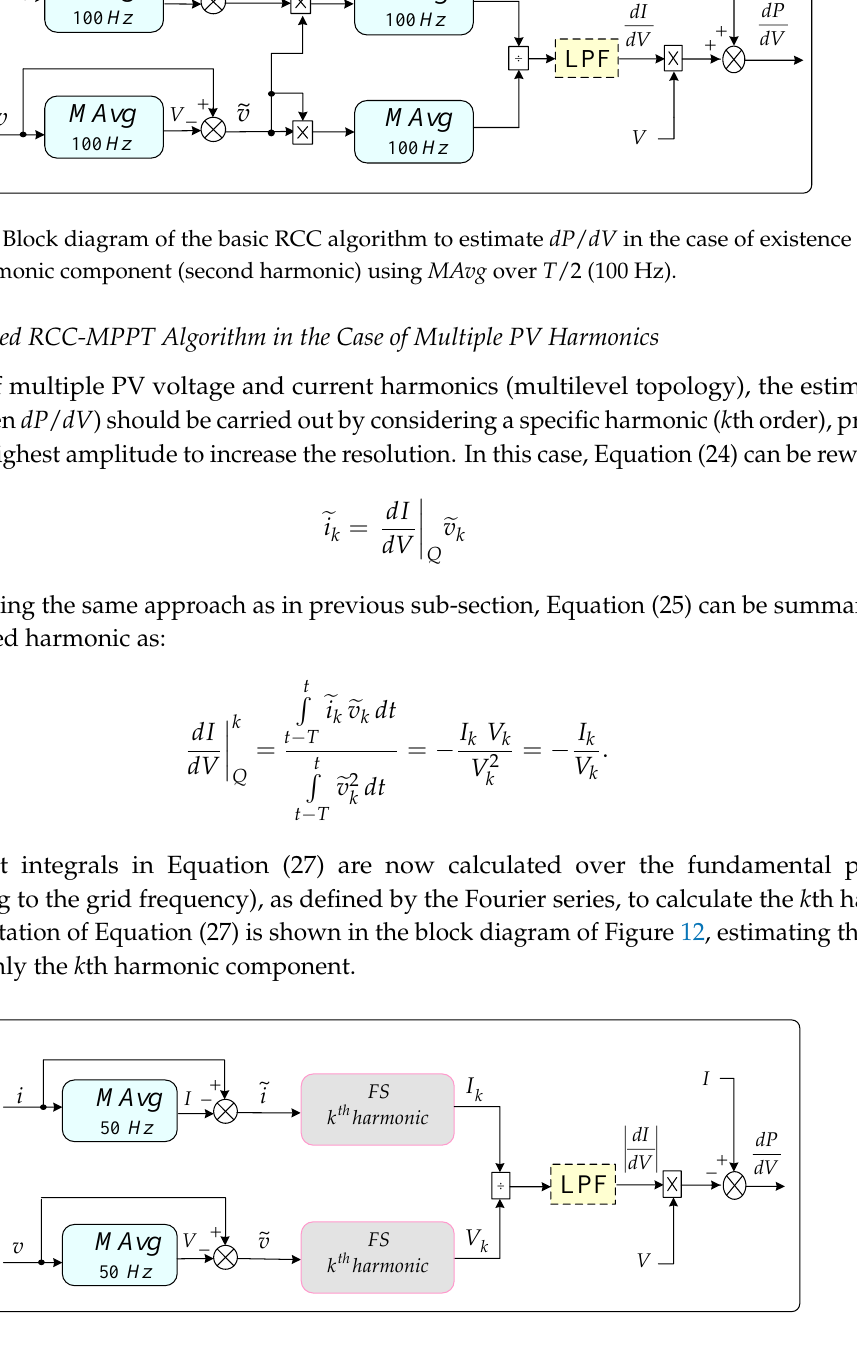
Figure 12. Block diagram of proposed RCC estimating dP / dV by a specific harmonic (Fourier series, FS).